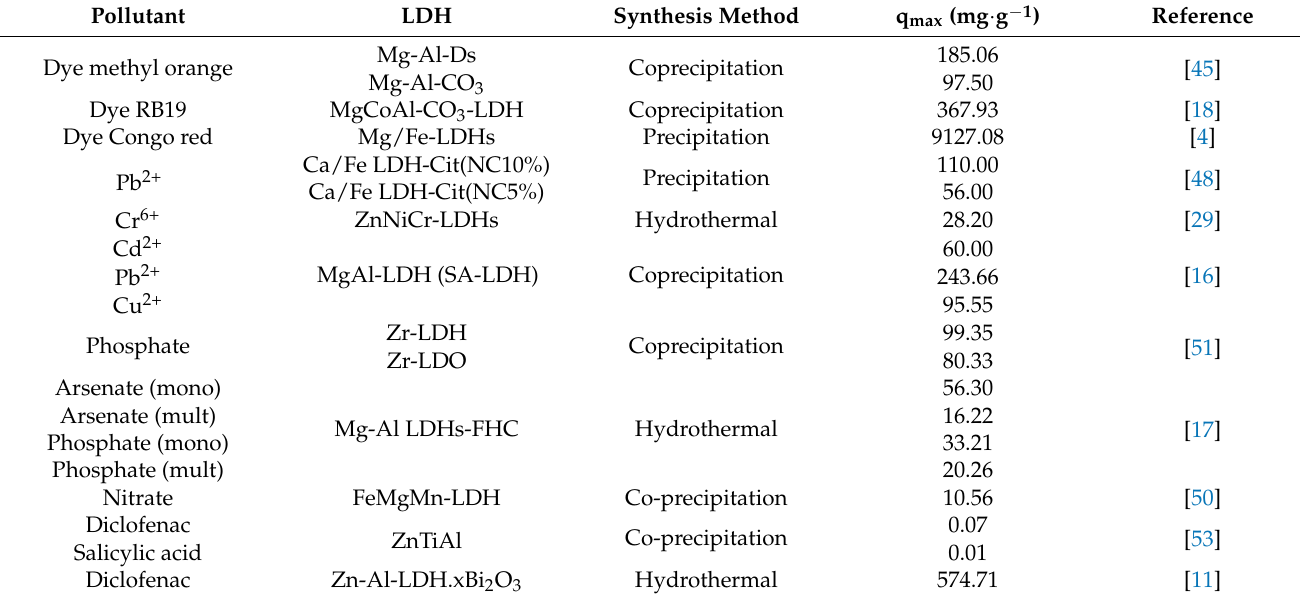
Table 3. Some characteristic works in which LDHs are used as adsorbents for organic and inorganic